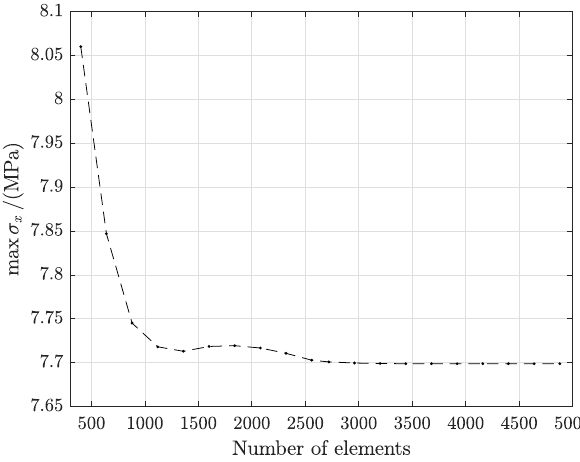
Figure A1. Closed vector loop derived from Fig. 3 as the basis for the derivation of the nonlinear equations.